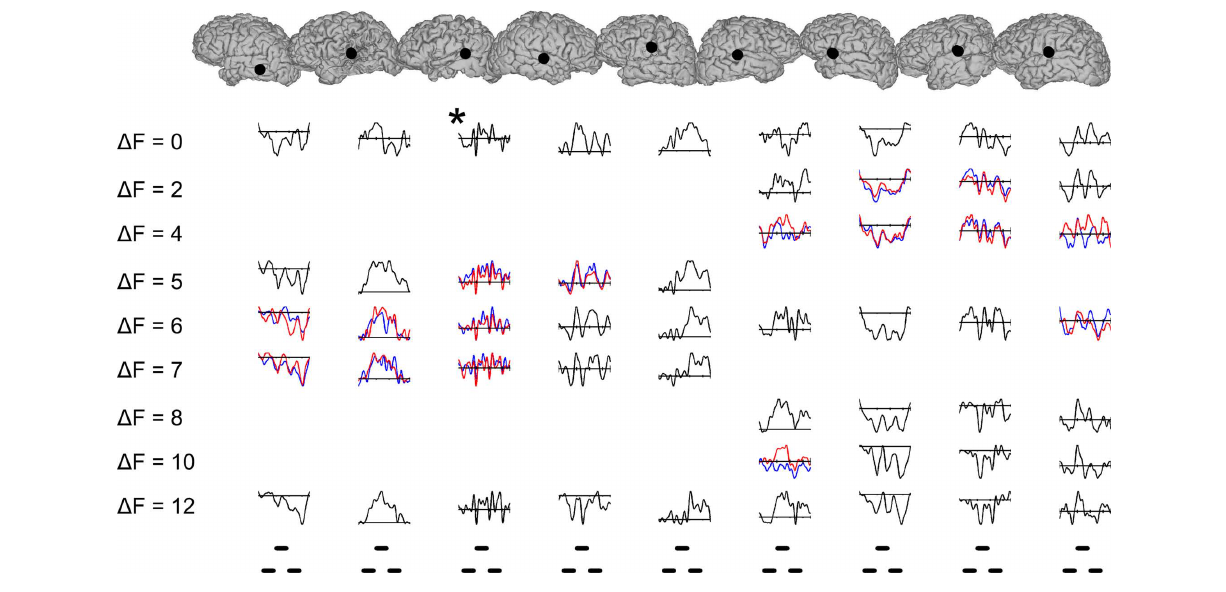
Figure 6 | evoked potentials from individual peri-Sylvian electrode sites in each of the nine subjects. Blue and red traces for a given frequency separation and subject indicate that the percept for that condition was bistable (*, this patient did not understand the task). Waveforms traced in black indicate that the percept for that condition was unstable. Electrode sites, shown in the top row